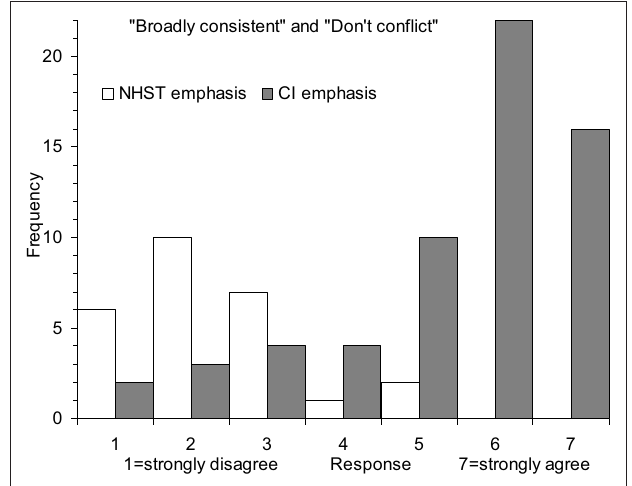
Figure 8 | Frequency histograms of rating responses in experiment 2 to the “broadly consistent” and – after reversal – “there is conflicting evidence” statements (that together yield the Consistent score), separately for text responses classified as showing an NHST emphasis, or a Ci emphasis. Responses indicate strength of agreement the two studies described in Figure 1 are consistent and do not